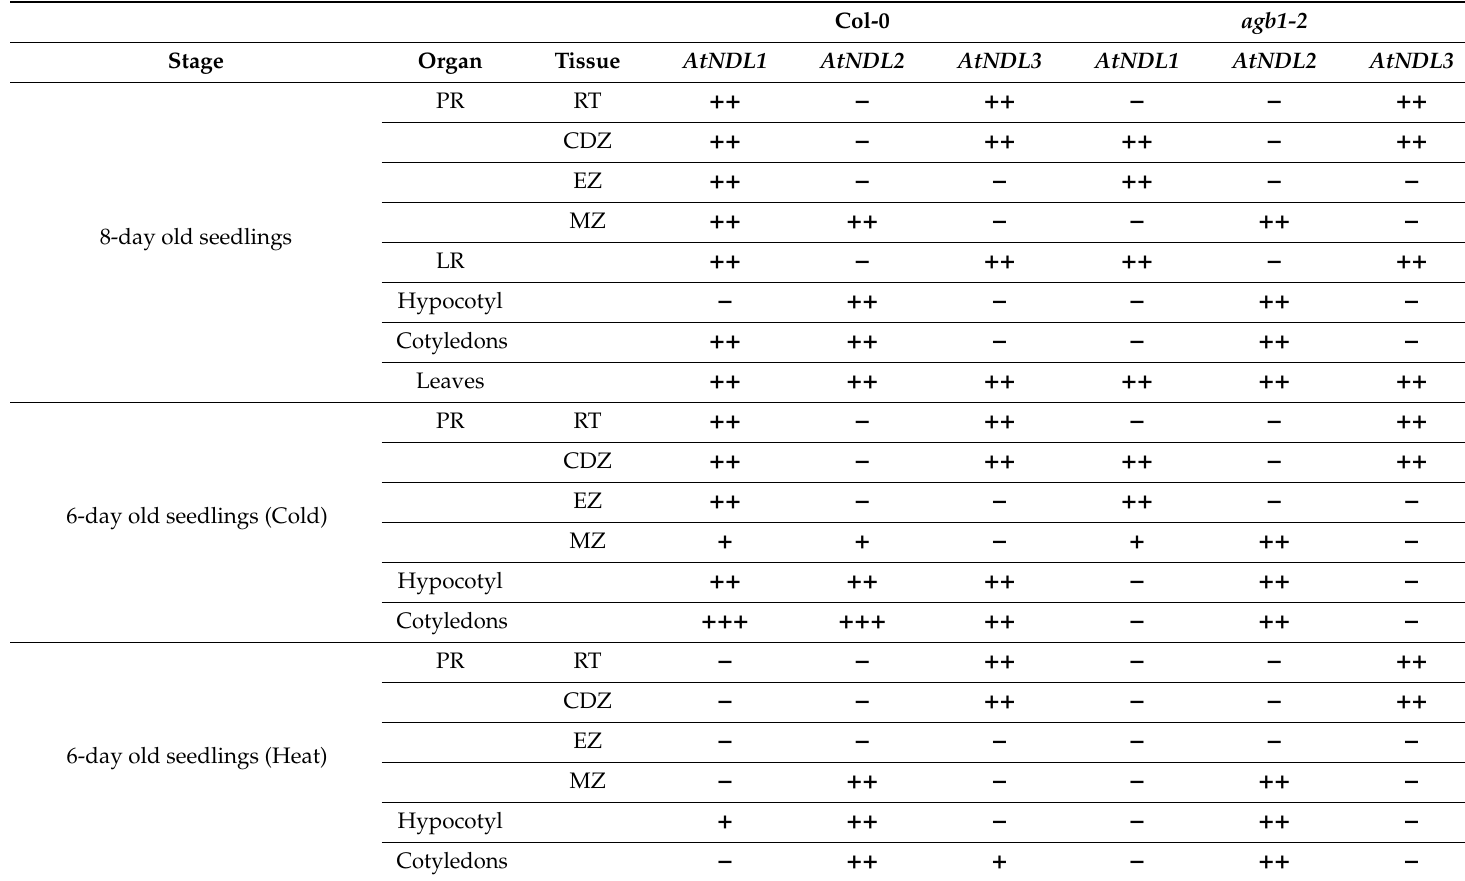
Table 3. AtNDLs localization during various stages of development and after abiotic and hormonal